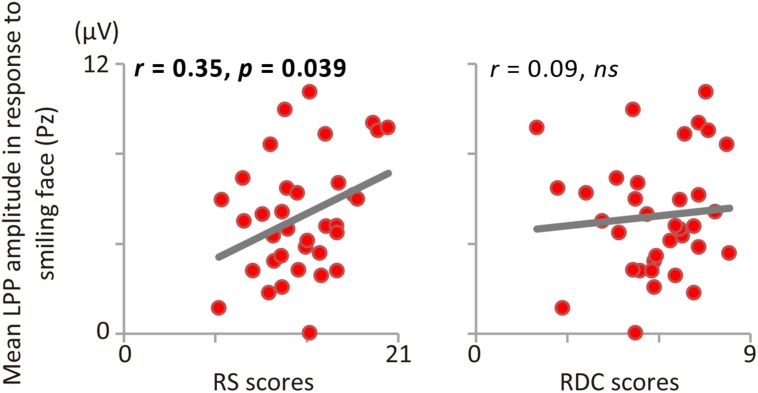
Correlations between LPP amplitude in response to smiling faces and RS (left), RDC (right).